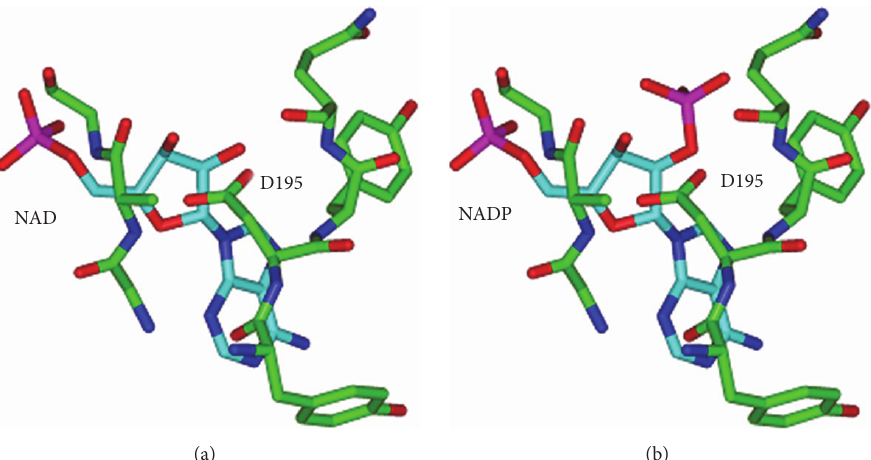
Figure 1: Homology modelling of cm FDH based on Pseudomonas sp . 101 FDH without mutation in the coenzyme binding domain. (a) Coenzyme is NAD + . (b) Coenzyme is NADP +